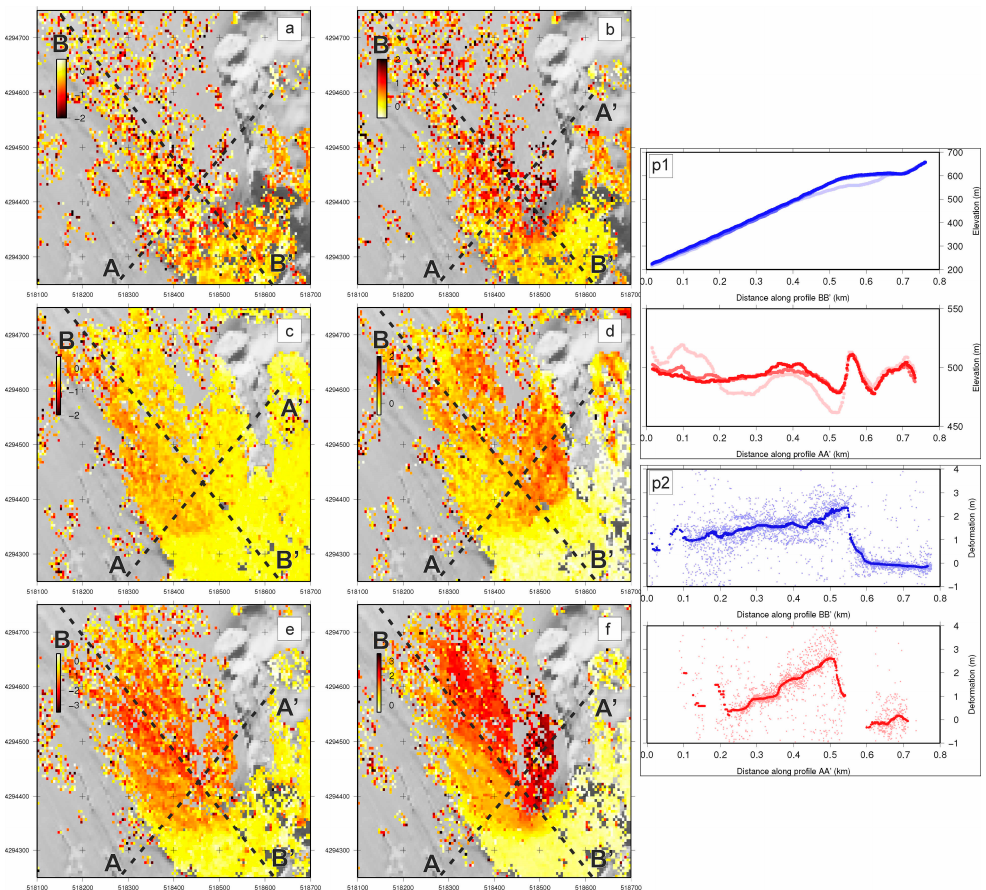
Figure 3. Maps showing the magnitude of the horizontal deformation (meters). From top to bottom, panels ( a , b ) show horizontal displacements from September 2003 to August 2004; ( c , d ) from August 2004 to May 2005 and ( e , f ) from September 2003 to May 2005. Left column (panels a , c , e ) shows EW component. central column (panels b , d , f ) shows NS component. ( p1 ) Digital elevation models (DEM) profiles: blue profile indicates the AA', corresponding to the maximum slope direction; BB' is shown in red. Color intensities indicate different dates, darker more recent; see Figure 2 for profile tracks. ( p2 ) North–South deformation component profiles for the September 2003 to May 2005 periods (blue—AA'; red—BB' profiles). See Figure 2 for profiles location. Note that the maximum deformation values correlate well with the areas with a maximum change in elevation between DEMs at different epochs.